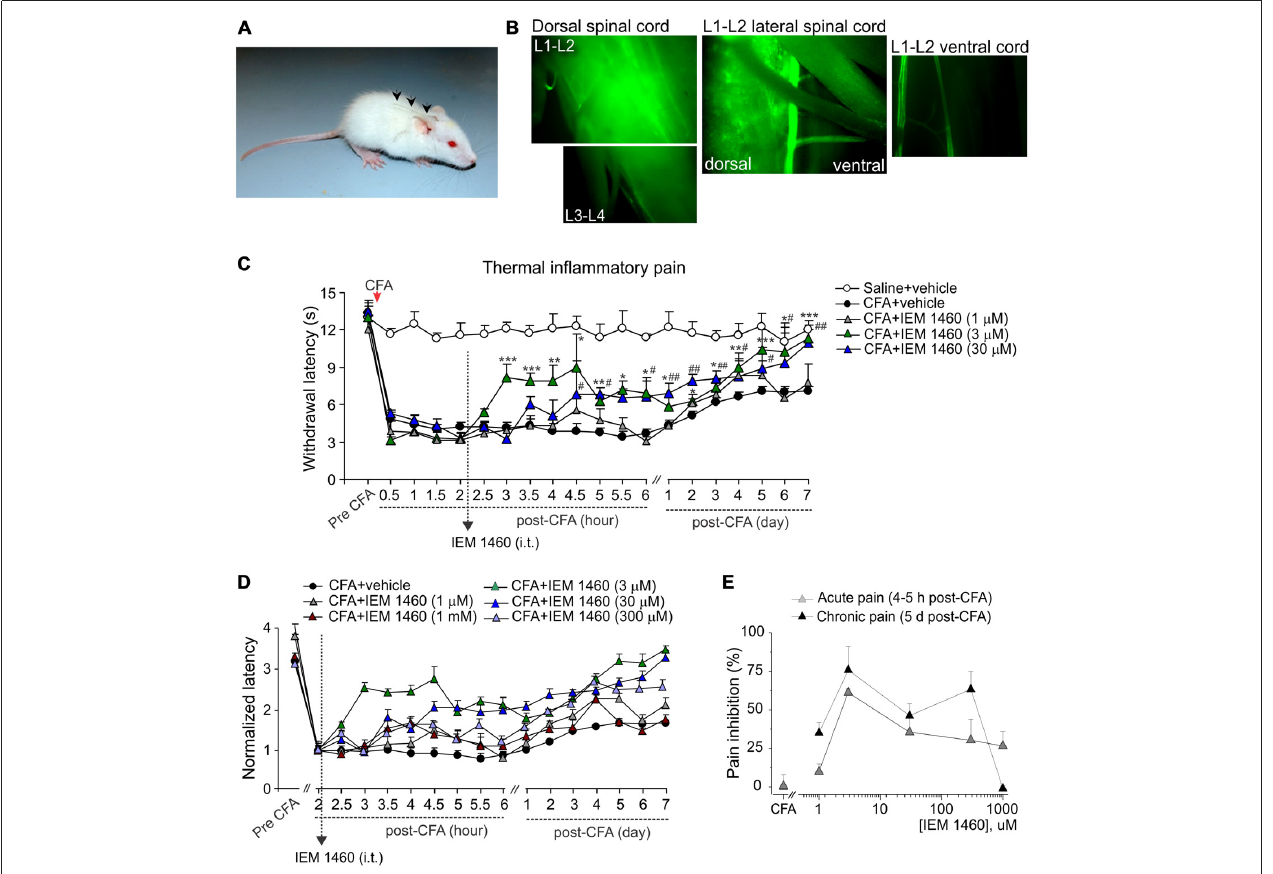
FIGURE 1 | The concentration-dependent alleviation of thermal nociceptive hypersensitivity by the dicationic compound IEM-1460. (A) Photograph of a rat with implanted catheter into spinal cord column. (B) Fluorescent images of different areas of freshly dissected spinal cord after i.t. injection of morphological dye Alexa-594 (100 µ M, 10 µ l) into the lumbar spinal cord showing the fluorescence in the dorsal spinal cord (lumbar segments), but not in the ventral spinal cord with notably dim fluorescent signal along the attached roots. (C) Hargreaves pain behavioral test in different groups of animals demonstrates that post-treatment of complete Freund’s adjuvant (CFA)-induced inflammatory pain with the dicationic compound IEM-1460 alleviates thermal pain hypersensitivity in rats. Data are expressed as mean ± SEM. ∗ p < 0.05, ∗∗ p < 0.01, ∗∗∗ p < 0.001 for 3 µ M of IEM-1460 vs. the correspondent time-point in the CFA-inflamed group. # p < 0.05, ## p < 0.01 for 30 µ M of IEM-1460 vs. the correspondent time-point in the CFA-inflamed group. One-way analysis of variance (ANOVA) and Bonferroni post hoc test. (D) The paw withdrawal latencies in different groups of animals treated with IEM-1460 were normalized to the correspondent value prior to starting the treatment (2 h) to demonstrate the time-dependence of pain relief on the compound concentration. (E) The concentration-inhibition curves of IEM-1460-induced inhibition of inflammatory pain for the acute and the long-lasting